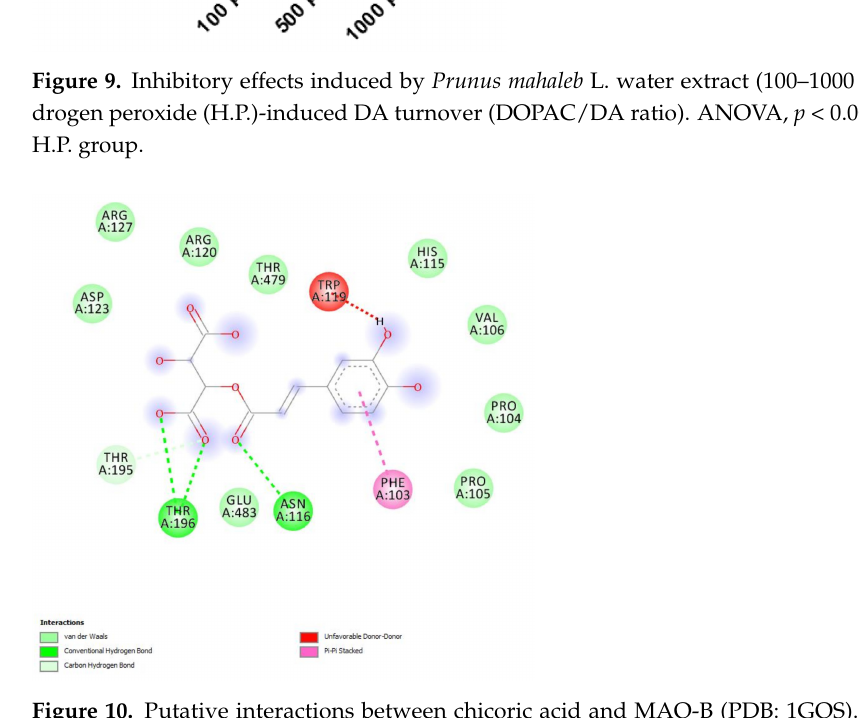
Figure 10. Putative interactions between chicoric acid and MAO-B (PDB: 1GOS). Free energy of binding ( ∆ G) and affinity (Ki) are − 7.6 kcal/mol and 2.3 µ M,